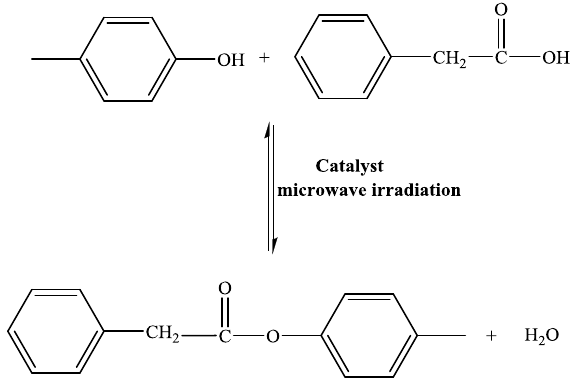
Figure 9. Schematic representation of synthesis of p-cresyl phenylacetate [108] .